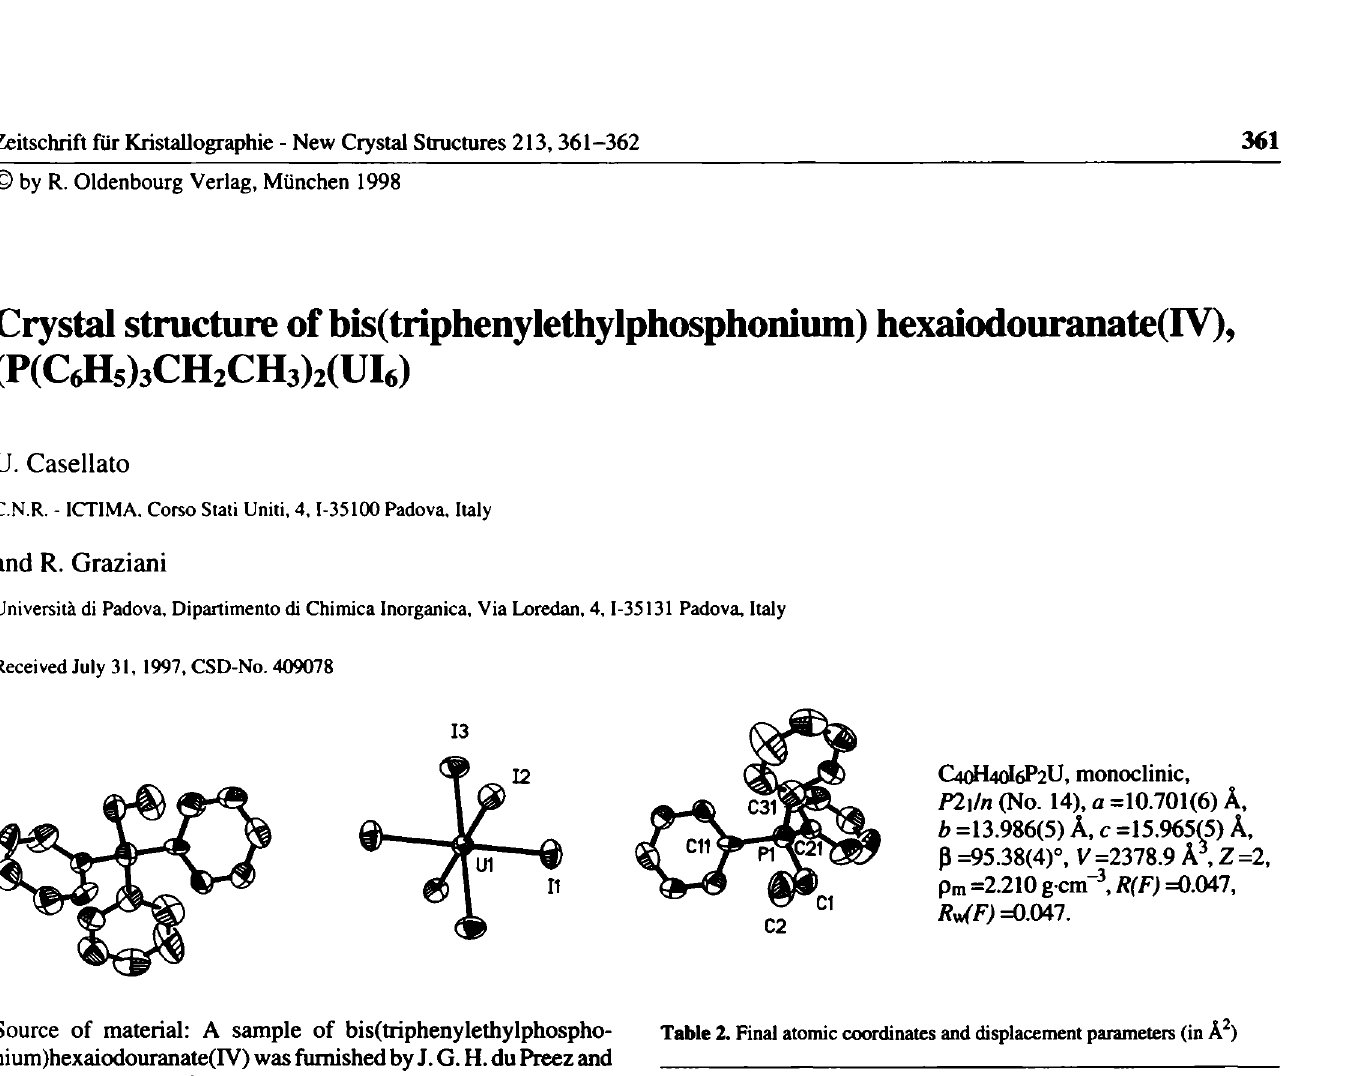
Table 2. Final atomic coordinates and displacement parameters (in Â^)